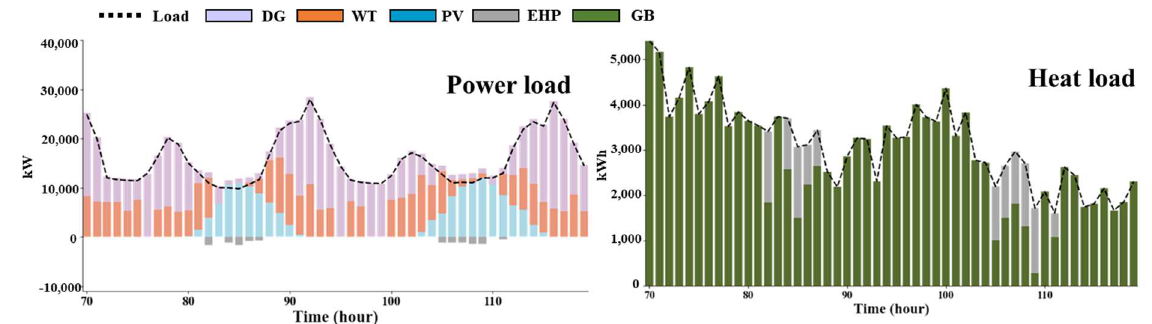
Figure 5. Results of power flow scheduling in Case 1.